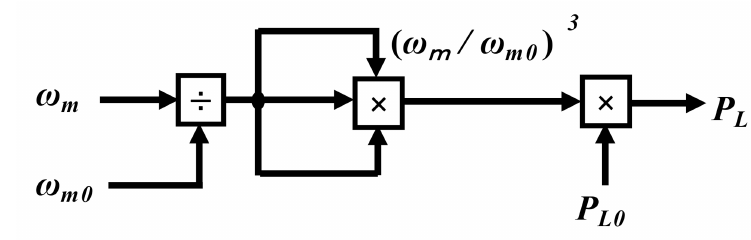
Figure 8. Pumping load model in pumping operation mode.